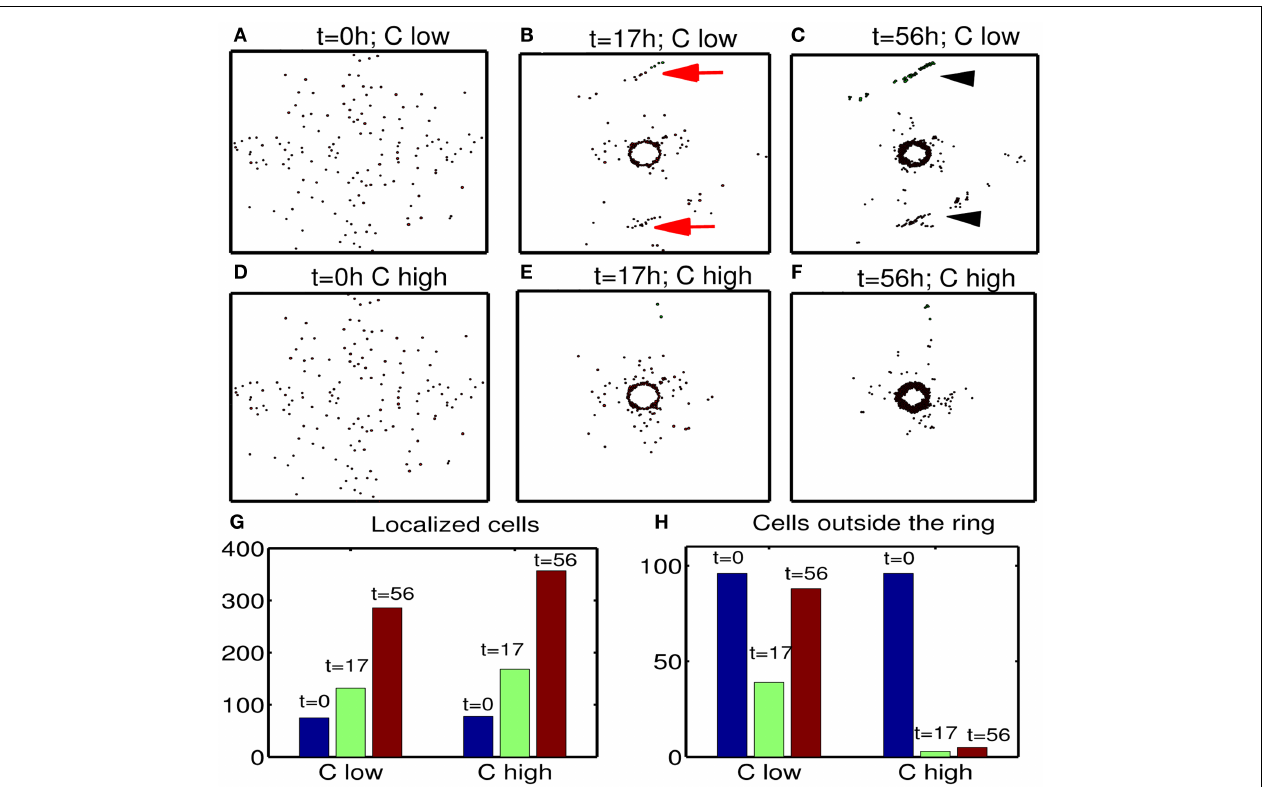
growth later at the undesirable location (black arrowheads in (C) ). Domain ) on efficacy of the in size = [0 . 1, 0 . 9] × [0 . 1, 0 . 9] ⊂ [0, 1] 2 . (G) Populations of localized cells (cells = λ C / 10 ) and in in with d < 0 . 25) for low (10-fold smaller) and high levels of chemoattractant. Here, d = (cid:112) ( x i − 0.5 ) 2 + ( y i − 0.5 ) 2 is the distance from cell location ( x i , y i ) to the center (0.5, 0.5) of the domain. (H) Same as in (G) but for cells outside the localized domain (cells with d > 0 . 25). Parameters used: t G